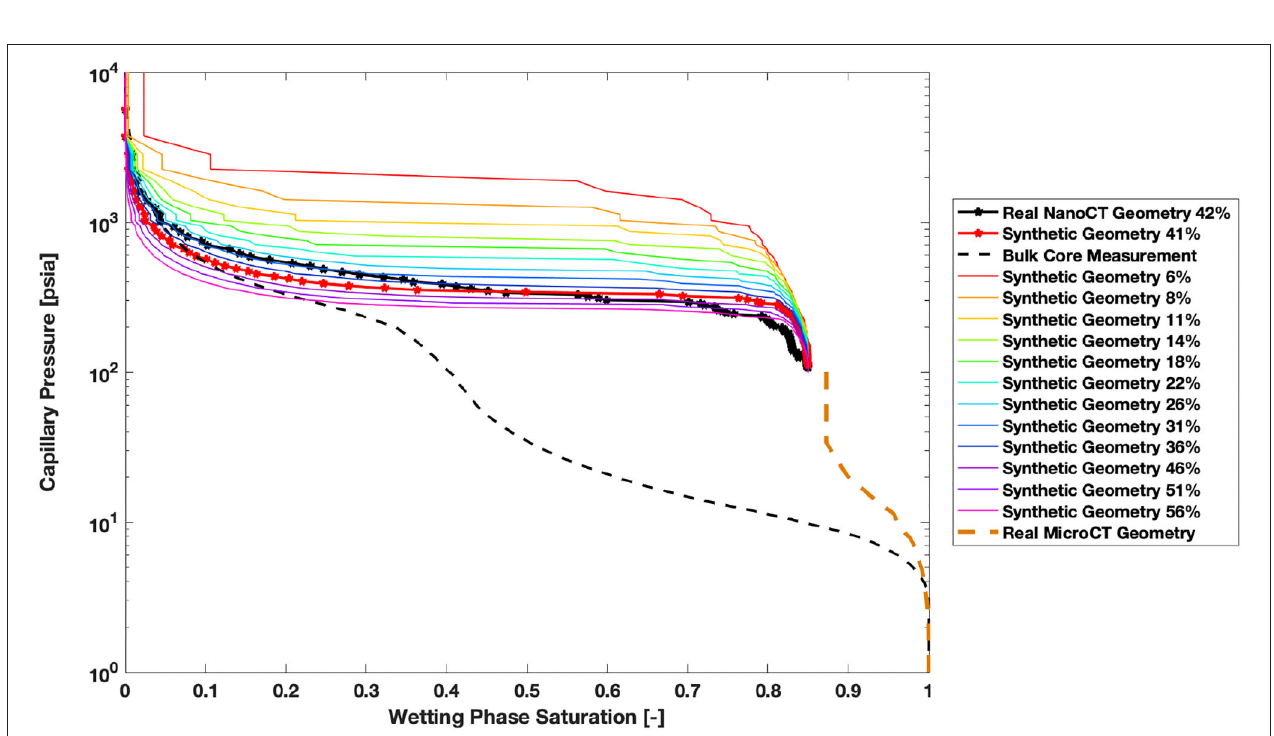
FIGURE 4 | The real nano-XRM (solid black), real micro-CT (solid brown), synthetic (red and rainbow), and bulk core measured (black dashed) MICP curves. Values are normalized to total porosity.